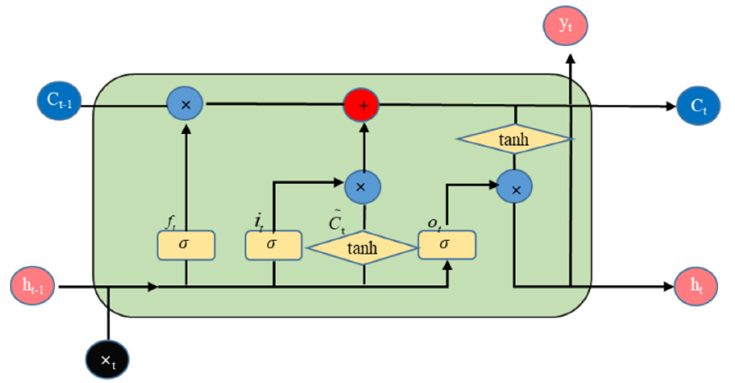
Figure 6. Schematic of a typical LM